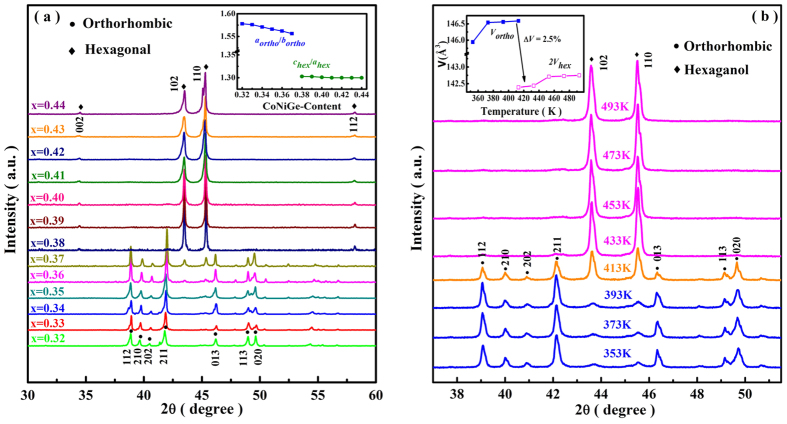
Structural analysis of the phase transitions.(a) Composition dependent XRD patterns of (MnNiSi)1−x(CoNiGe)x measured at RT. Inset: aortho/bortho and chex/ahex ratios. (b) Temperature-dependent XRD of (MnNiSi)0.66(CoNiGe)0.34 from 353 to 493 K. Inset: cell volumes from 353 to 493 K for (MnNiSi)0.66(CoNiGe)0.34.